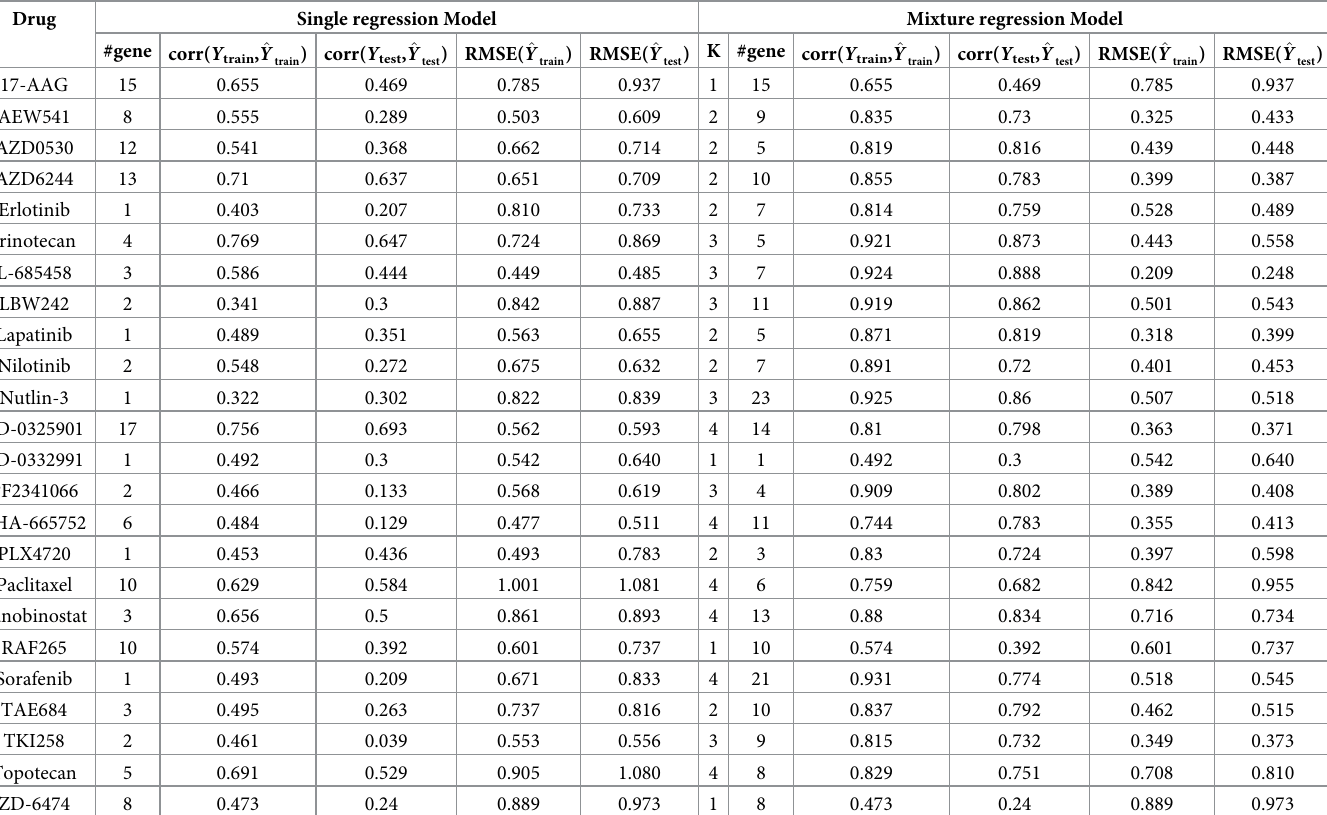
Table 4. Comparison of the single component regression model and mixture regression model for the CCLE dataset, where #gene denotes the total number of differ- ent genes selected by the model. Drug Single regression Model Mixture regression